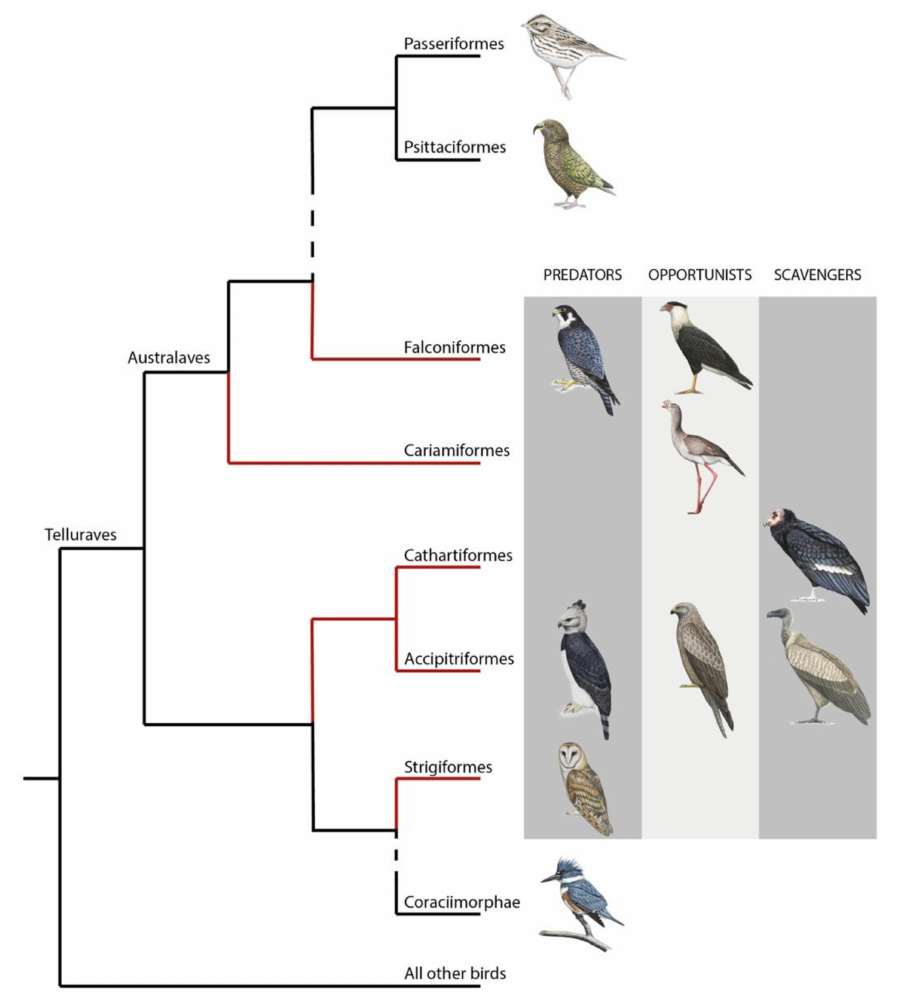
Figure 1. Phylogeny of core landbirds modified from [10]. The red branches encompass the order considered as raptors. For each order belonging to raptors, the presence / absence of the three foraging diet categories (predators, opportunists and scavengers) is represented by a drawing of a chosen species. “Raptor” is a paraphyletic group where species mostly share the raptorial lifestyle passed down from their single common ancestor [10]. This assumes that raptorial lifestyle has been lost twice independently with the ancestor of both Coraciimorphae and Passeriformes / Psittaciformes clades. Coraciimorphae contains six orders: Coliiformes (mousebirds), Trogoniformes (trogons), Coraciiformes (roller, kingfishers, and bee-eaters), Piciformes (woodpeckers), Leptosomiformes (cuckoo-rollers), and Bucerotiformes (hoopoes and hornbills). Drawings from Bryce W.